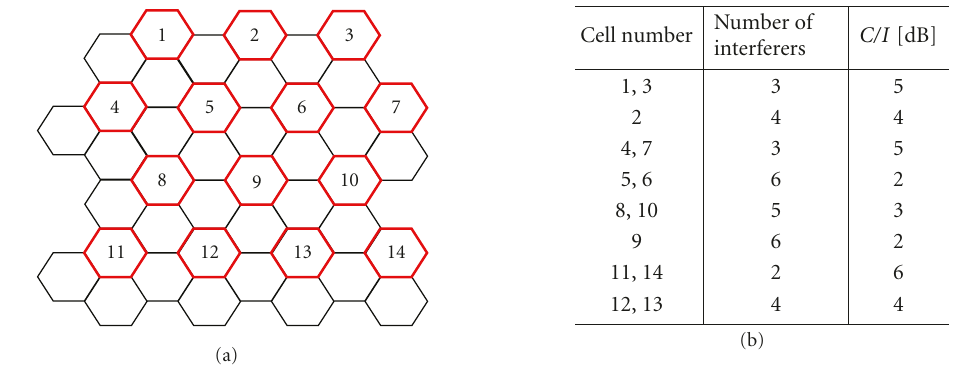
Figure 3: Description of the studied